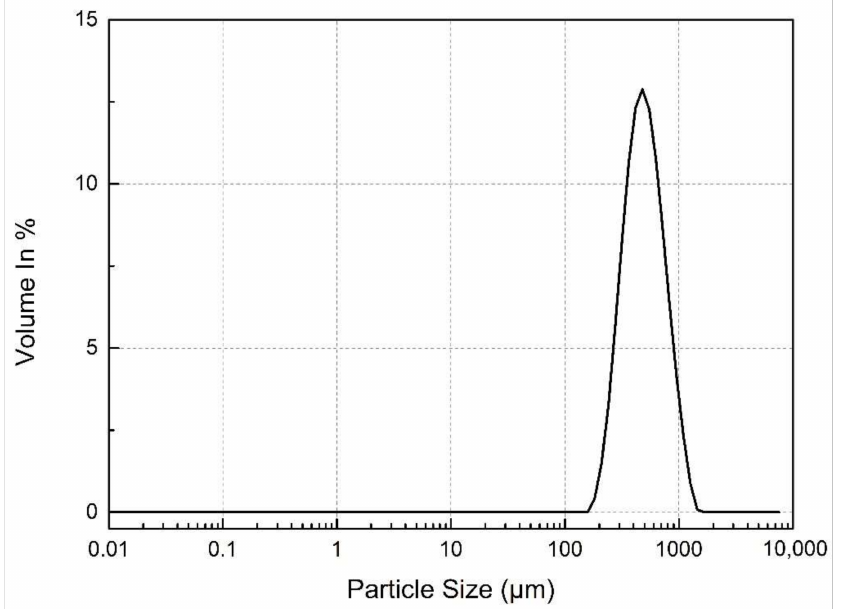
Figure 4. Particle size distribution of